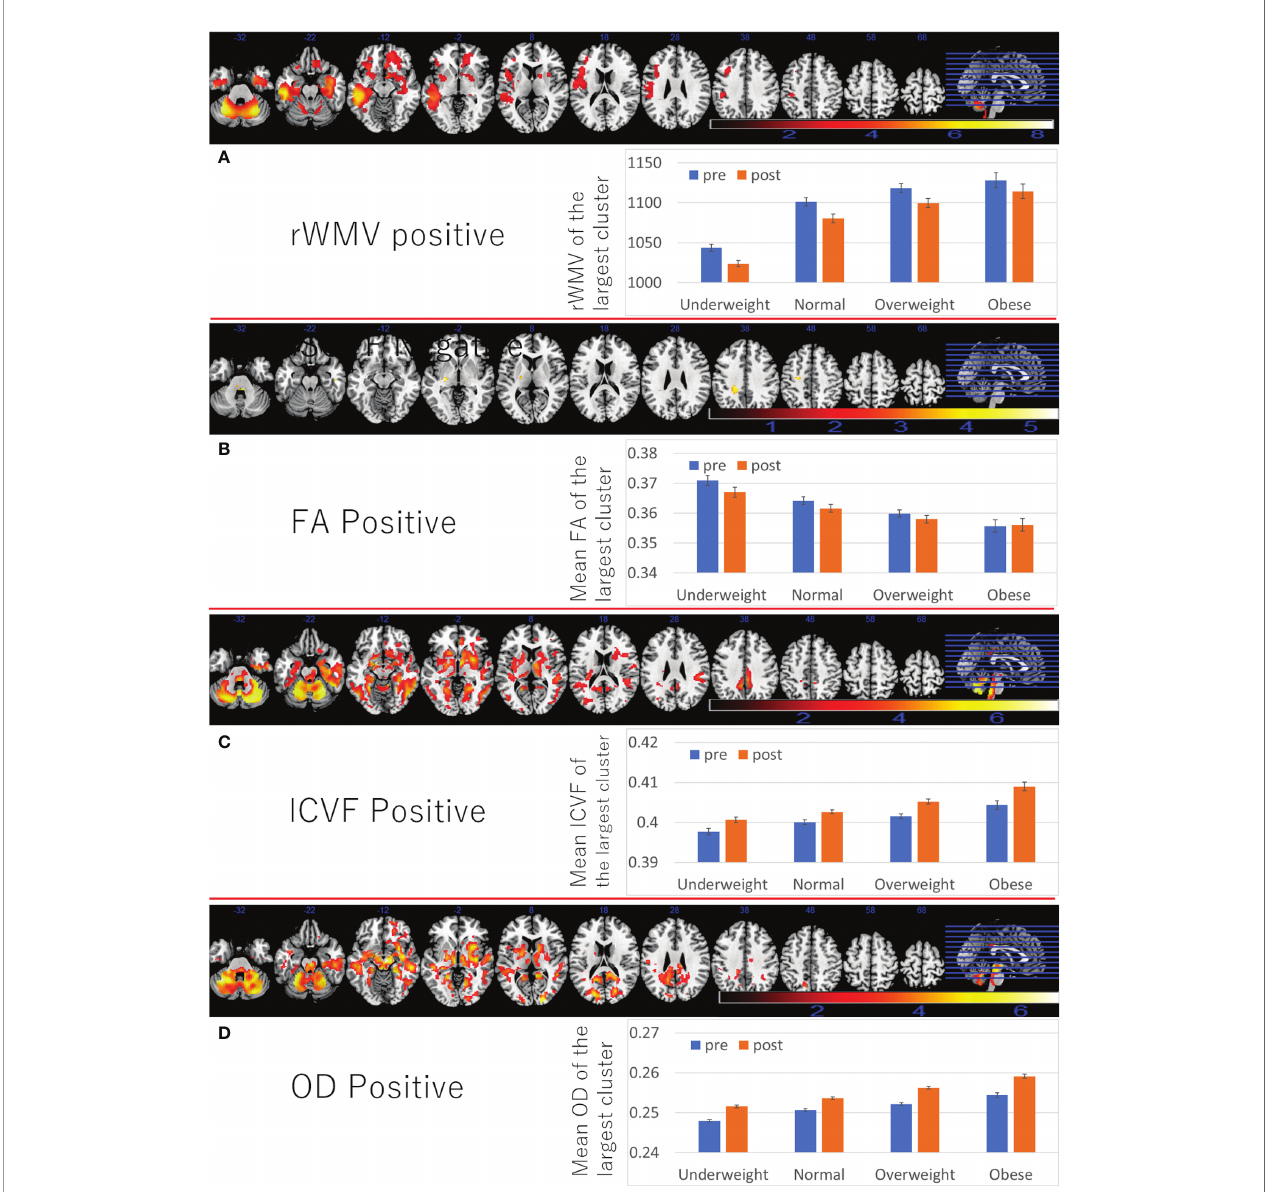
FIGURE 4 | Associations between BMI and subsequent longitudinal changes in brain imaging measures. Positive associations between BMI and (A) rWMV change, (B) FA change, (C) ICVF change, (D) OD change. (Left panels) Results are shown with a threshold of P < 0.05 and corrections for multiple comparisons in cluster size tests with a voxel level cluster determining threshold of P < 0.05 (corrected for FDR). Areas of signi fi cant associations were overlaid on a “ ch2bet ” image using MRIcron (https://www.nitrc.org/projects/mricron) and in slices (from the left) of z = -32, -22, -12, -2, 8, 18, 28 38, 48, 58, and 68. The color represents the strength of the T value. (Right panels) Pro fi les of imaging values at pre and post scans (which correspond to the third and the fourth assessment visits) in the largest signi fi cant clusters of each